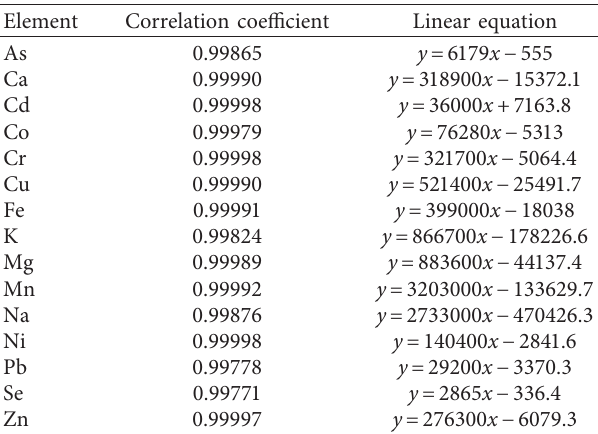
Table 3: Analysis wavelengths of the element. Table 4: Correlation coefficients and linear equations of all elements.